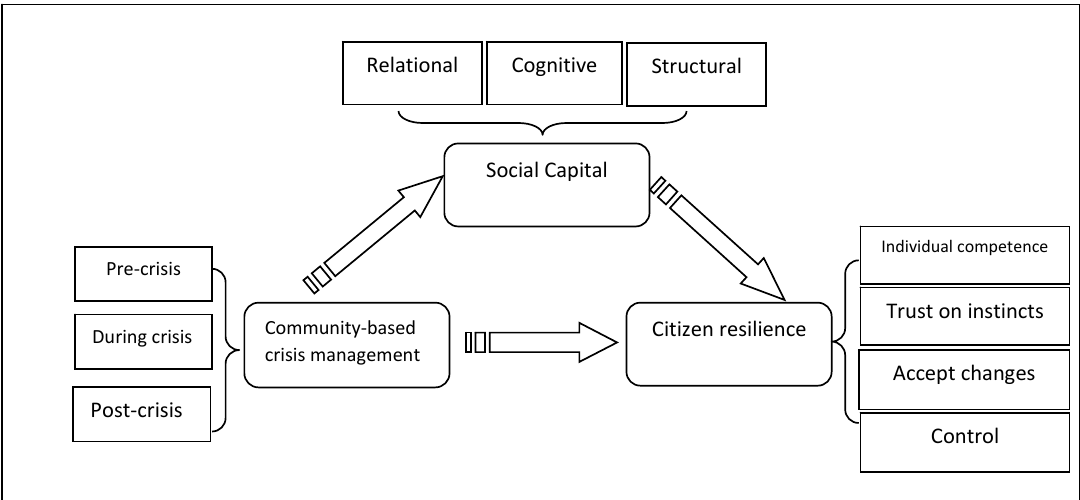
Fig. 1: Research conceptual